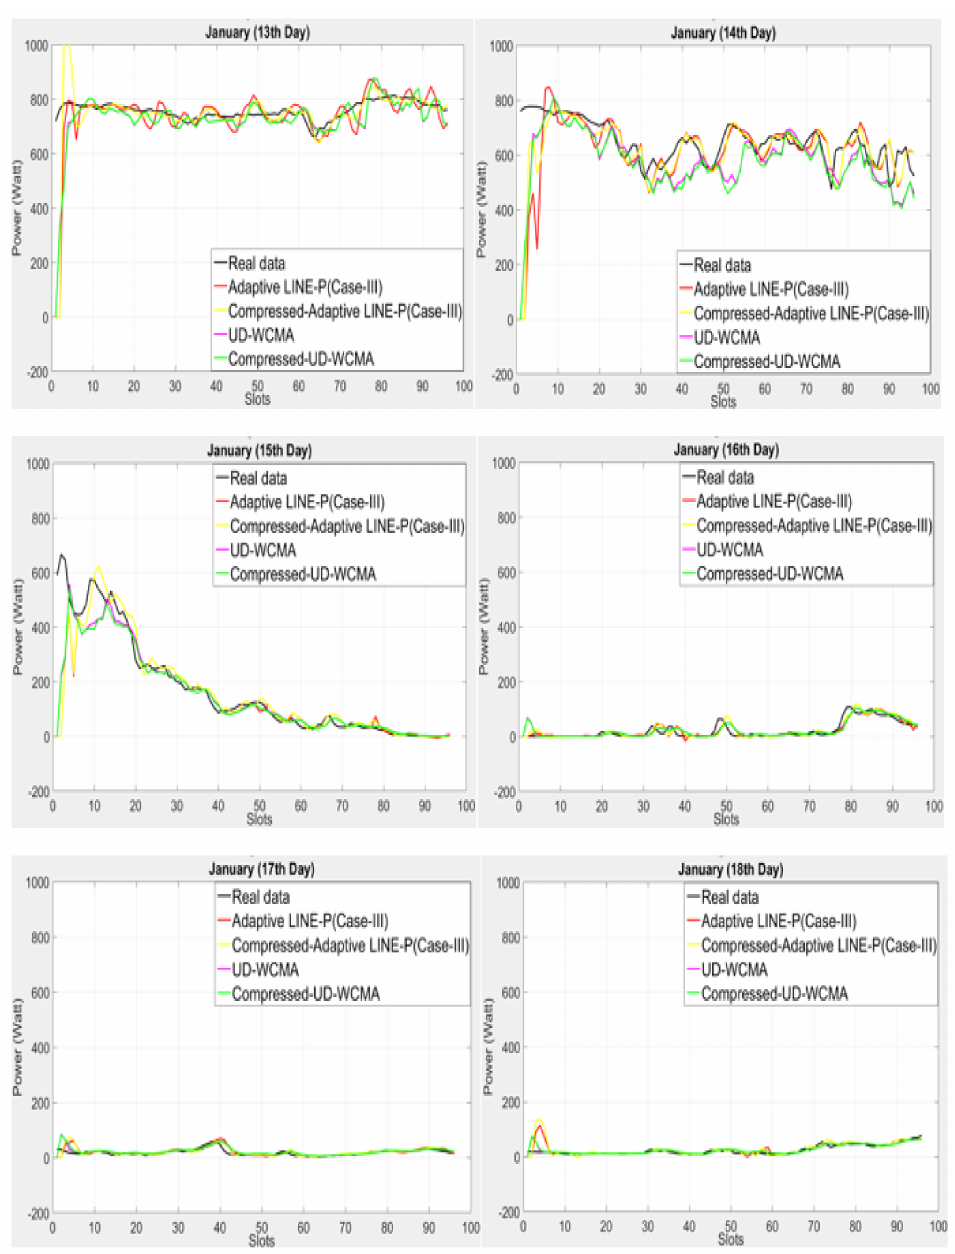
Figure 9. Graphical representation of energy prediction models with and without the compressed profile method based on the short time period horizon of the wind energy profile